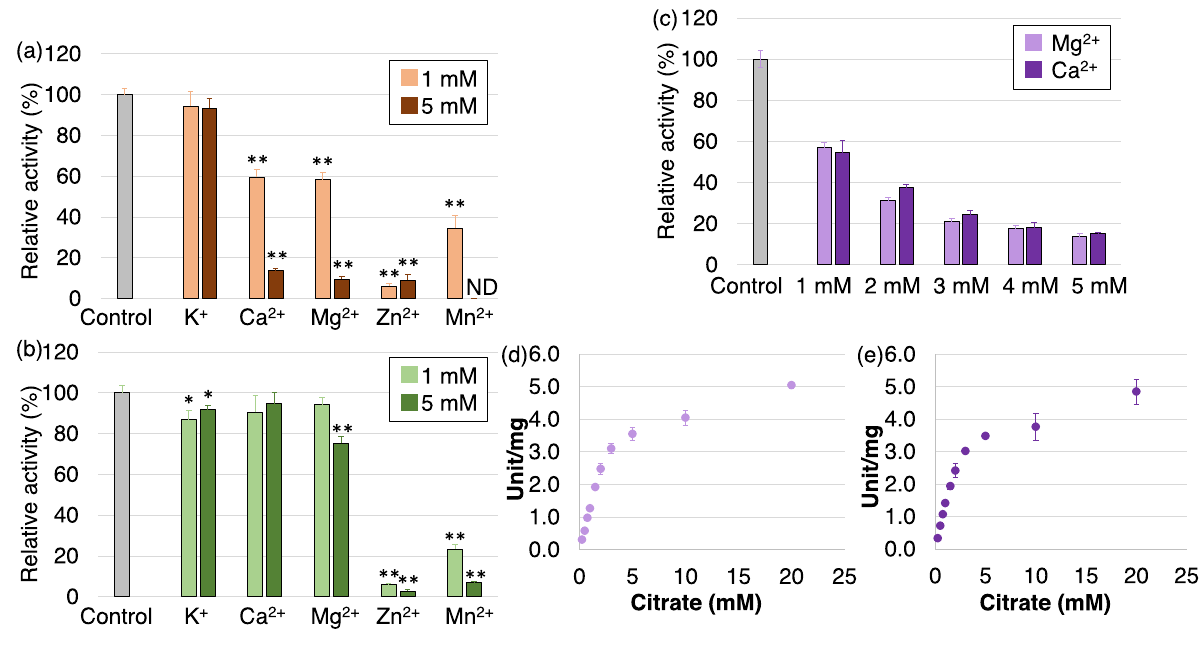
Figure 6. Effect of various cations on the activity of Sy AcnB. ( a ) The experiment was performed using ( a ) 1.13 mM trisodium citrate dihydrate in Tris–HCl buffer pH 7.7 at 45 °C and ( b ) 1.54 mM dl-isocitrate trisodium salt hydrate in Tris–HCl buffer pH 8.0 at 53 °C. The asterisks indicate significant differences compared to the Sy AcnB activities at the control condition (Student’s t -test; * P < 0.05, ** P < 0.005). ND, enzymatic activity not determined; K, KCl; Ca, CaCl 2 ; Mg, MgCl 2 ·6H 2 O; Zn, ZnSO 4 ·7H 2 O; Mn, MnCl 2 ·4H 2 O. ( c ) The activities were measured using 1.13 mM trisodium citrate dihydrate and Tris–HCl buffer pH 7.7 at 45 °C in the presence of ( c ) 1–5 mM Mg 2+ or Ca 2+ , ( d ) 1 mM Mg 2+ , and ( e ) 1 mM Ca 2+ . Mean ± SD values were calculated from three independent experiments. Sy AcnB, Synechocystis sp. PCC 6803 aconitase B; SD, standard